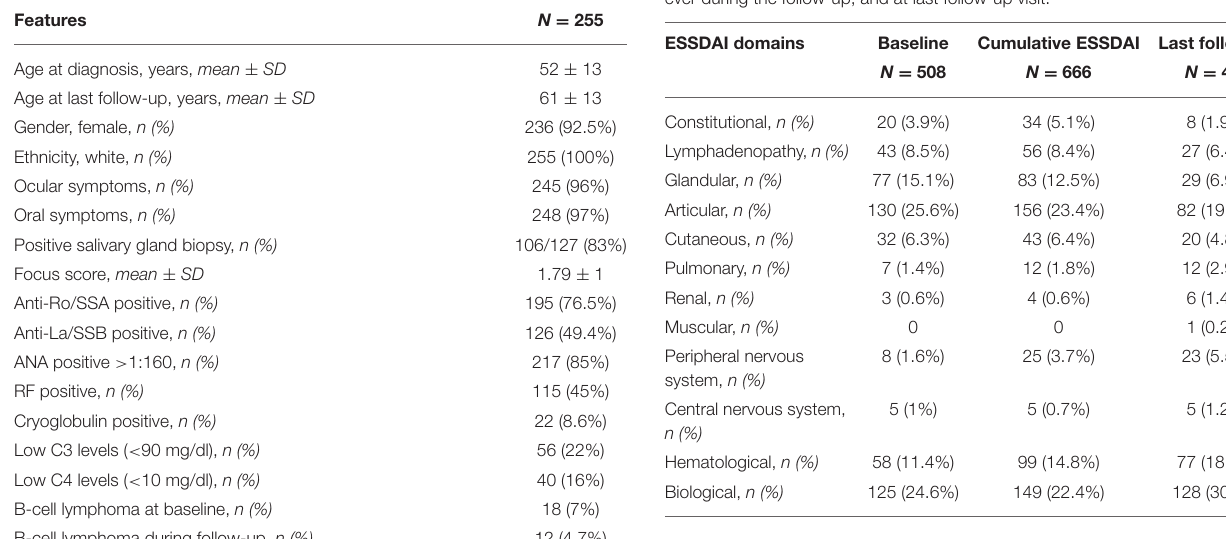
TABLE 1 | Baseline characteristics. TABLE 2 | Numbers and percentages of each active ESSDAI domain at baseline,